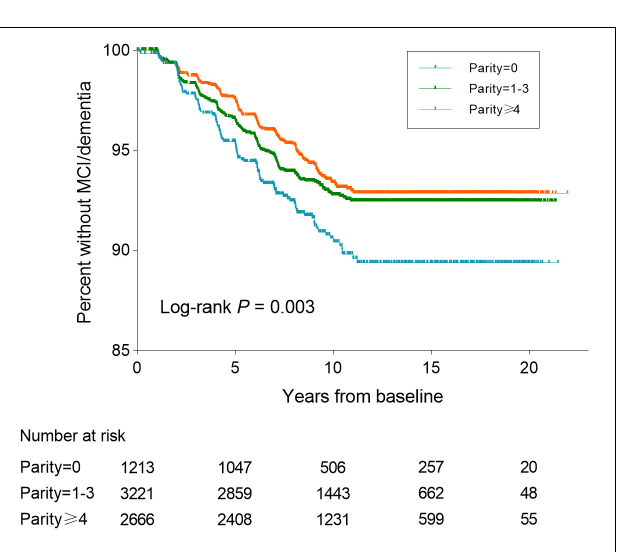
FIGURE 2 | Kaplan–Meier curves of survival to MCI/PD onset over the follow-up stratified by parity groups. MCI, mild cognitive impairment; PD, probable dementia.